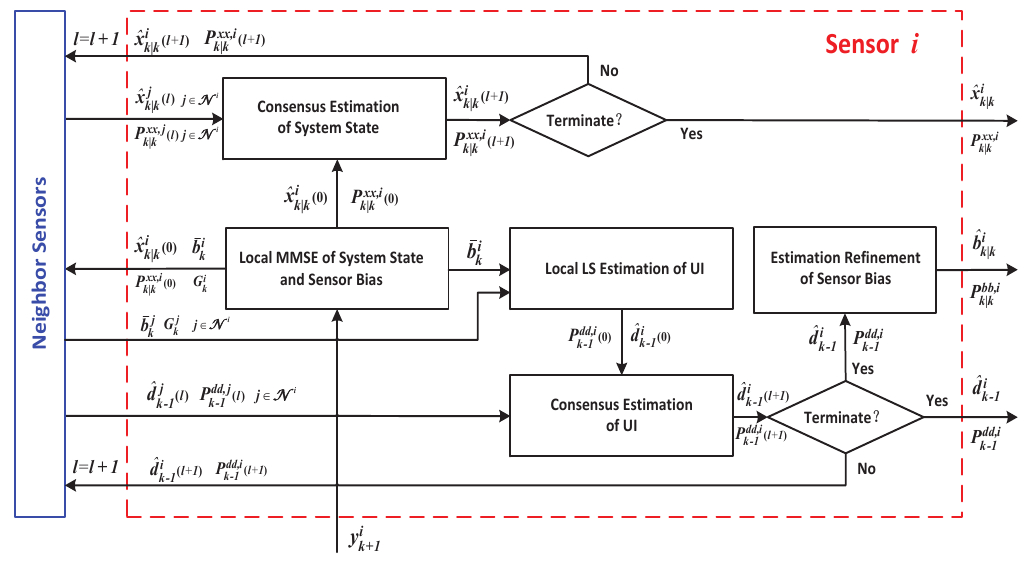
Figure 3. The scheme of the consensus estimation process for the target state and the UI. Table 2. Pseudo-code for the consensus